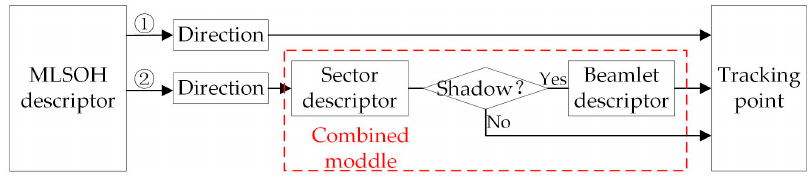
Figure 9. Acquisition of tracking points.